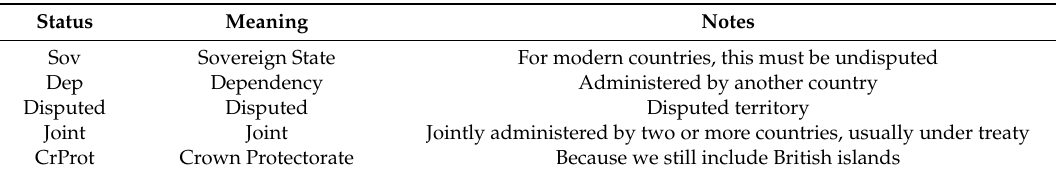
Table 2. Status values for